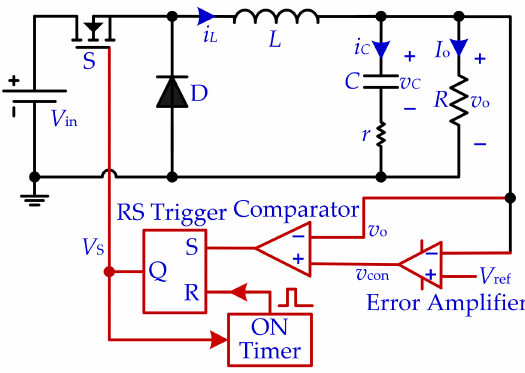
Figure 1. Schematic diagram of V 2 -COT-controlled buck